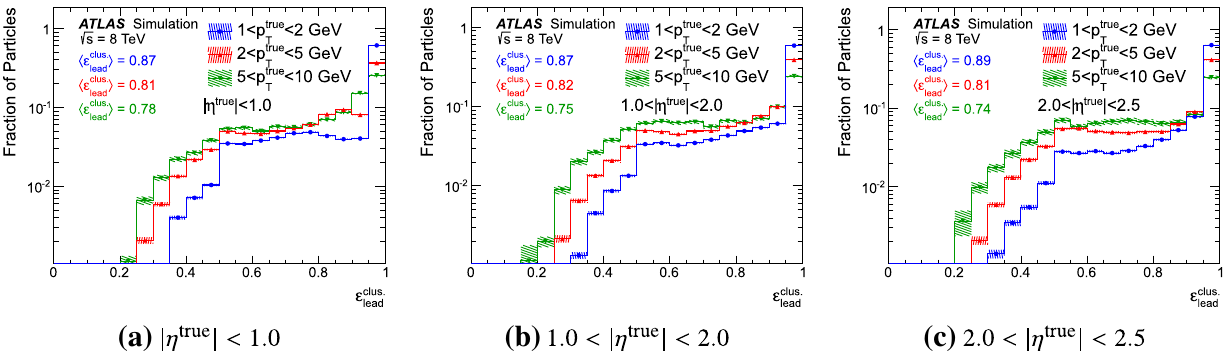
< 500GeV and the statistical uncer- without pile-up with 20 < p lead T tainties on the number of MC simulated events are shown as a hatched band